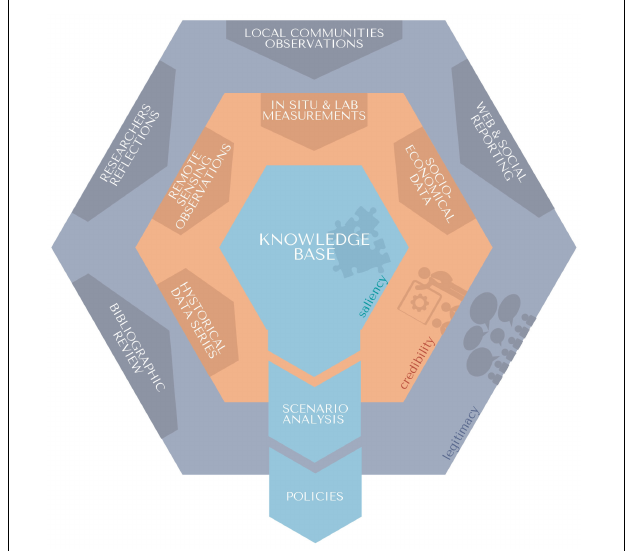
FIGURE 1 | A representation of the sources and the actors involved in the co-construction of knowledge in the whole SNAPSHOT project. While traditional research projects focus their attention on the production of scientific information, based on data and analysis (“credibility” layer), SNAPHSOT wanted to broaden the sources of knowledge to the perception of local communities, interest groups, media, and stimulate the reflections of the researchers involved (“legitimacy” layer). This broader vision on the processes taking place allows to bring out the knowledge base (“saliency” layer) necessary to face the analysis of the scenarios, from which future policies can